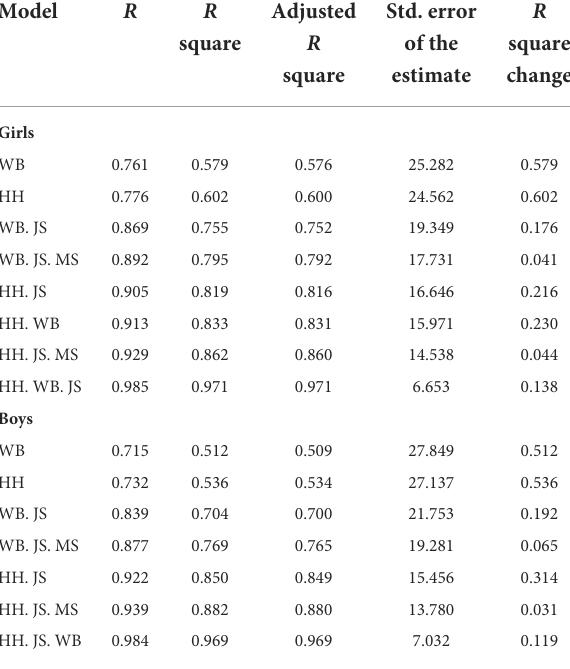
TABLE 6 Data from stepwise linear regression declared among TABLE 7 Data from stepwise linear regression declared among 10-year aged subject of both sexes. 11-year aged subject of both sexes. Model R R Adjusted Std. error R Model R R Adjusted Std. error R square R of the square square R of the square square estimate change square estimate change Girls